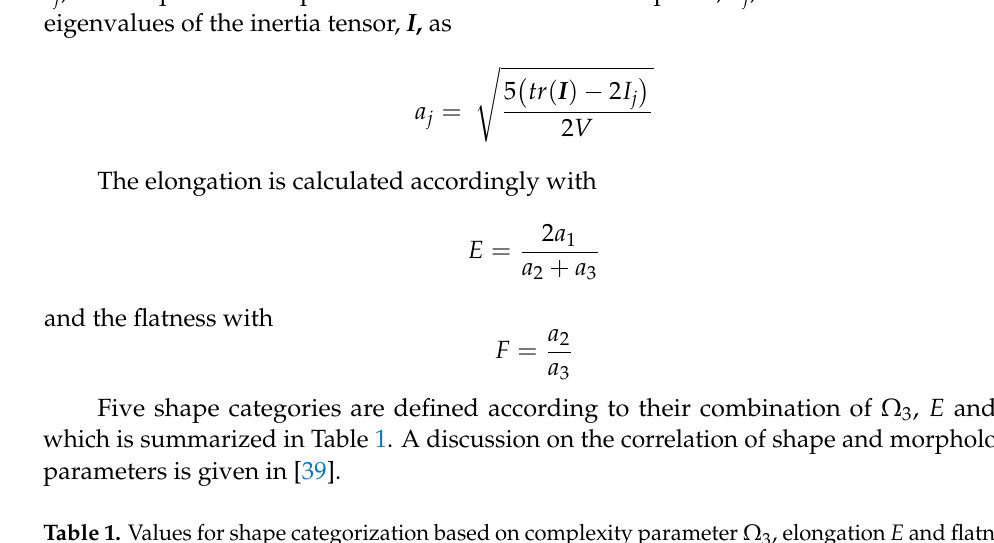
Table 1. Values for shape categorization based on complexity parameter Ω 3 , elongation E and flatness F [39]. E F Ω